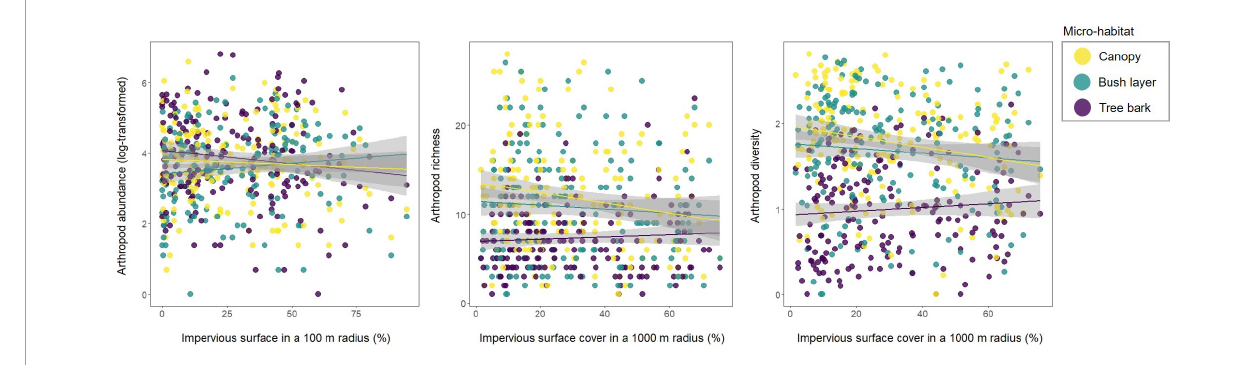
FIGURE3 Relationship between arthropod abundance (log-transformed), richness or diversity (Shannon diversity index), and impervious surface cover in a 100 m or 1000 m radius according to the micro-habitat (whatever the sampling month).